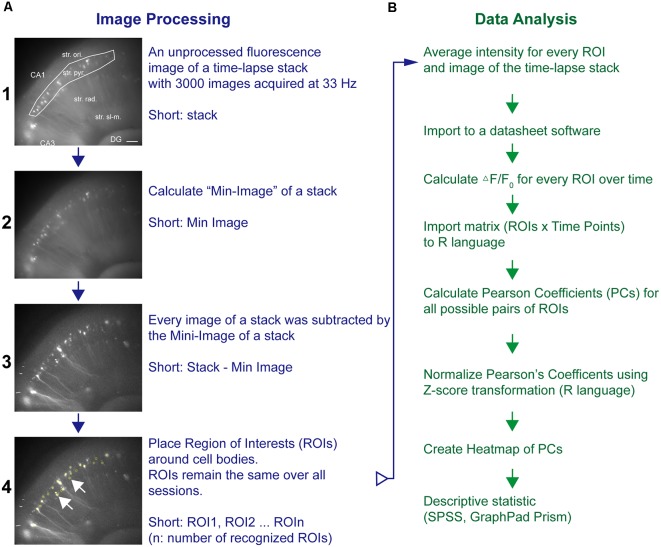
Pipeline of neuronal network analysis in hippocampal–entorhinal slices. The network analysis pipeline consists of (A) image processing and fluorescence intensity extraction followed by (B) cross-correlation analysis of fluorescence transients from different areas of a specific region. Fluorescence images in (A) represent representative examples after the respective imaging processing. The regions of interest (ROIs) were placed around neurons as shown in A4. Horizontal scale bar corresponds to 100 μm.